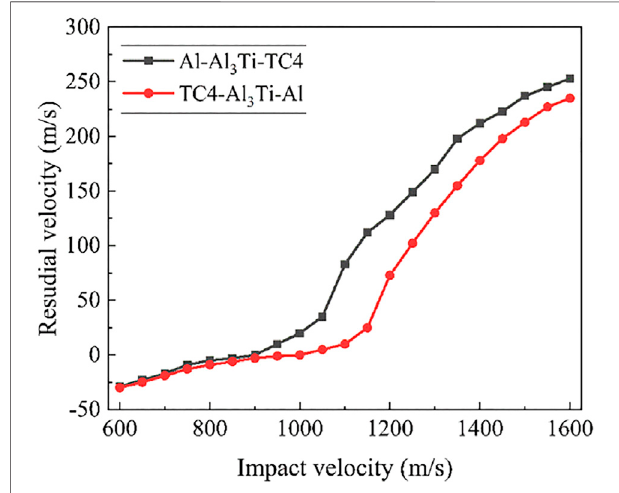
FIGURE 2 | Curves of impact velocity and residual velocity of TC4-Al 3 Ti- Al and Al-Al 3 Ti-TC4